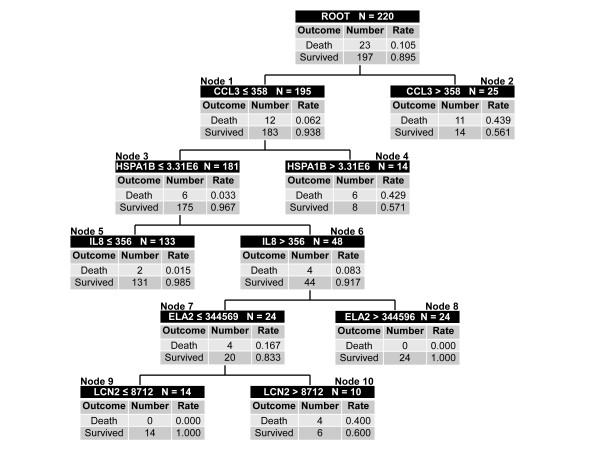
Classification tree from the derivation cohort (n = 220). The classification tree consists of five biomarker-based decision rules and ten daughter nodes. The classification tree includes five of the twelve candidate stratification biomarkers: C-C chemokine ligand 3 (CCL3), heat shock protein 70 kDa 1B (HSPA1B), interleukin-8 (IL8), elastase 2 (ELA2), and lipocalin 2 (LCN2). Each node provides the total number of subjects in the node, the biomarker serum concentration-based decision rule, and the number of survivors and non-survivors with the respective rates. For consistency, the serum concentrations of all stratification biomarkers are provided in pg/ml. Terminal nodes 5, 8, and 9 are considered low-risk nodes, whereas terminal nodes 2, 4, 10 are considered high-risk terminal nodes. To calculate the diagnostic test characteristics, all subjects in the low-risk terminal nodes (n = 171) were classified as predicted survivors, whereas all subjects in the high-risk terminal nodes (n = 49) were classified as predicted non-survivors. The area under the curve (AUC) for the derivation cohort tree was 0.885.